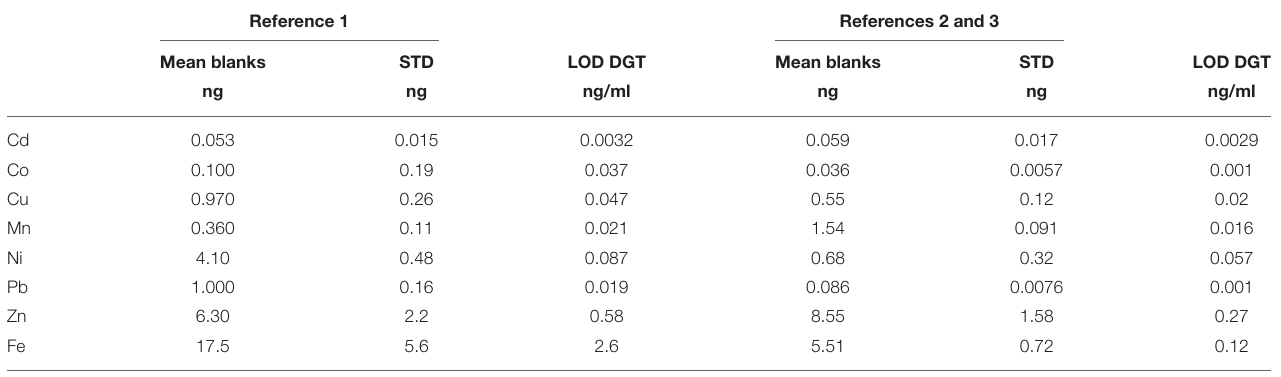
TABLE 2 | DGT blanks (with standard deviation STD) and Limits of Detection (LOD) for 24h exposure time. Reference 1